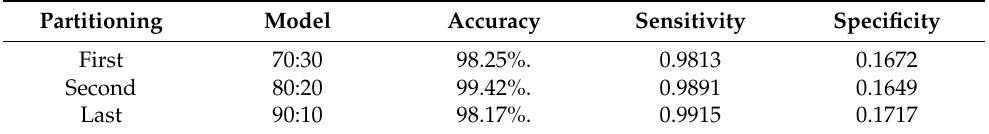
Table 3. The performance of the detection model.